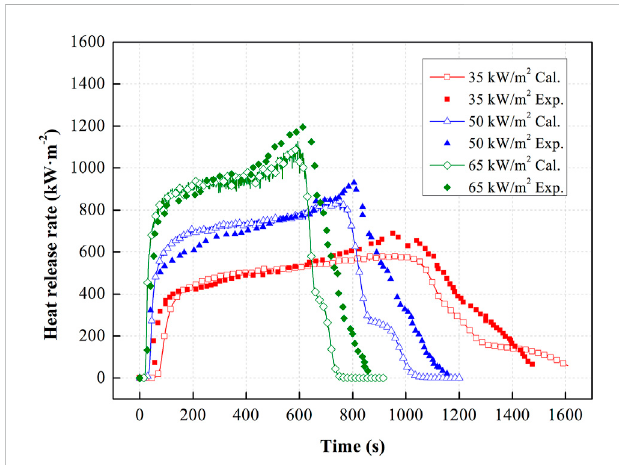
FIGURE 4 Theoretical and experimental heat release rate under different radiant heat fl